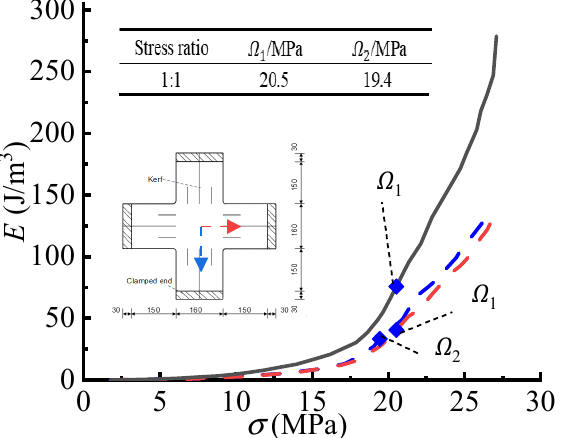
Figure 8. The σ − E curves of the cruciform specimen (1:1) and the detected essential principal stresses.